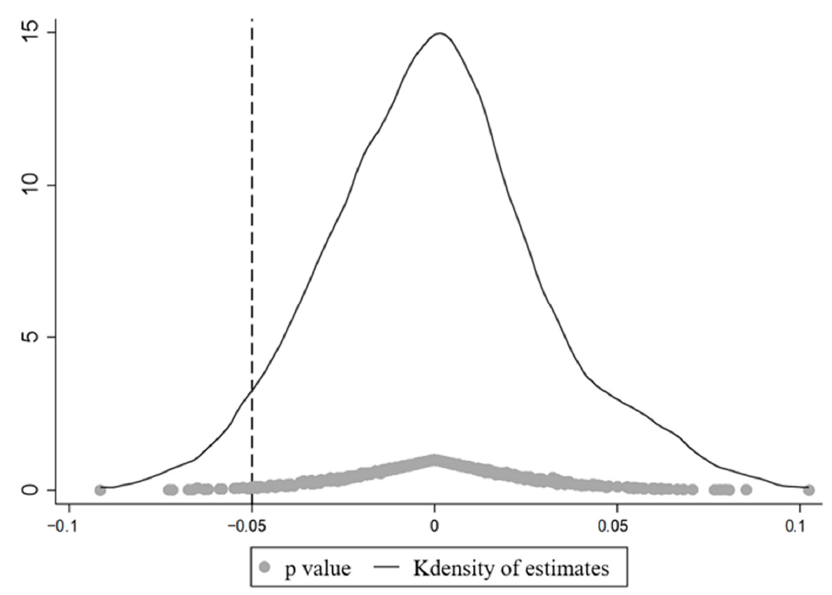
Figure 9. Results of the placebo test of FE.